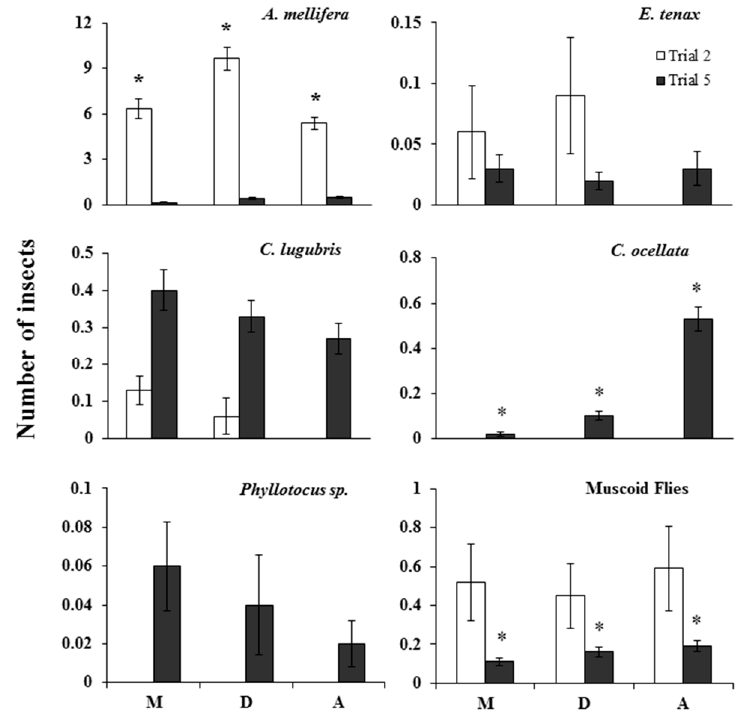
Figure 1. Number of insects (mean ± SEM) observed visiting carrot inflorescences for 5 min in the morning (M), midday (D), and afternoon (A) in trials 2 ( n = 8 days) and 5 ( n = 5 days). * Indicates significant differences at p < 0.05 using Friedman’s test.